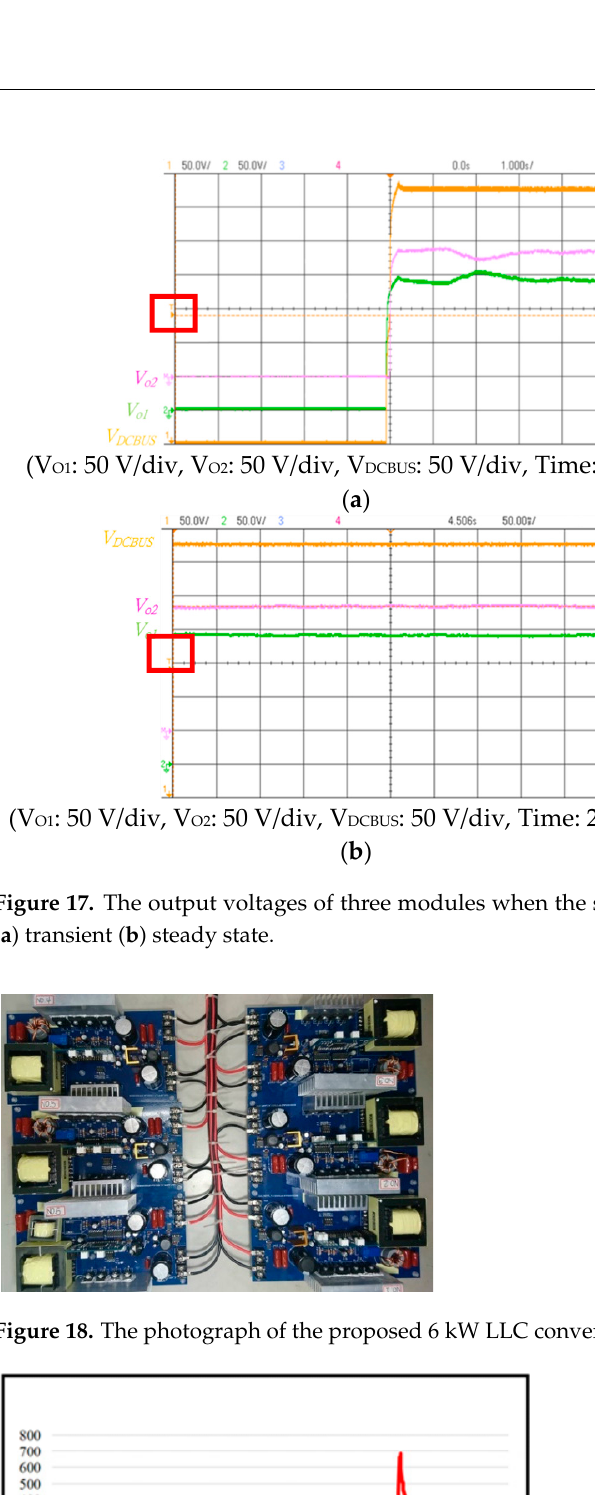
Figure 16. The system is operated in abnormal mode.